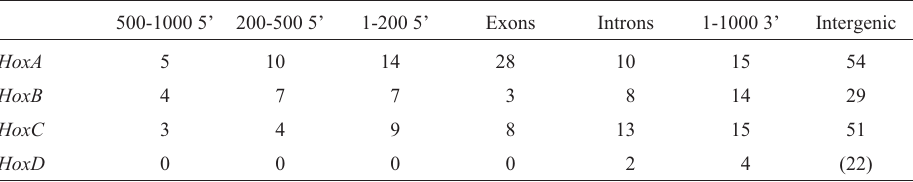
Table 2 - Number of short outlier regions of average conservation of 0.1 substitution per site, or better, falling into each distinct genomic domain. The intergenic domain number for HoxD has been parenthesized because of the earlier Ensembl gene prediction at the location where many of the conserved regions have been found.